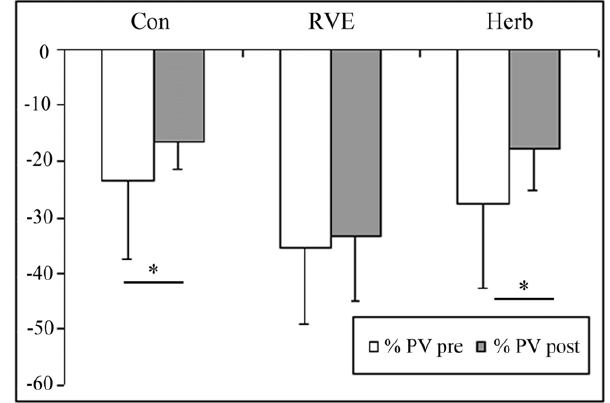
Figure 4. Percentage change in flow in the portal vein flow (PV) from supine to tilt positions. The PV was measured by echography as detailed in the Materials and Methods section. The percent change in the PV from supine to tilt positions decreased less post-HDBR in Con and Herb groups (p , 0.05), but there was no change in the RVE gr. RVE contributed to maintain splanchnic vasoconstriction in response to tilt- induced fluid shift.